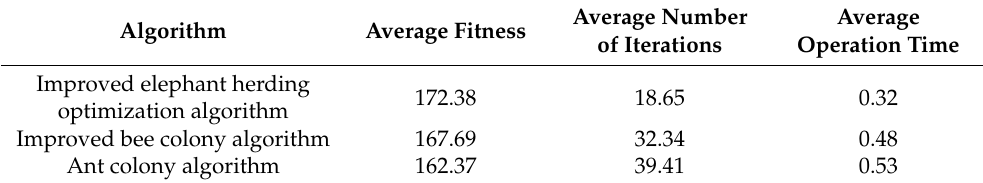
Figure 10. Three algorithm fitness value changes at the 25 s time. Table 2. Comparison and analysis of performance of three algorithms.